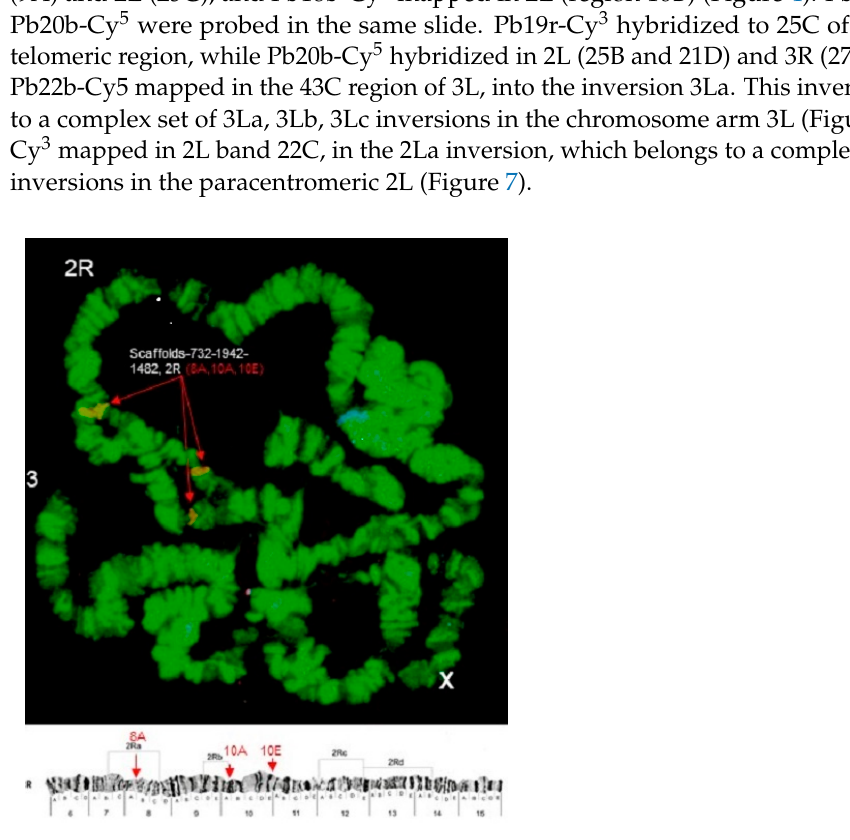
Figure 1. Pb2r-Cy3 probe, mapped in 2R (8A,10A, and 10E) indicated by arrows. 2Ra, 2Rb, 2Rc and 2Rd show inversions in 2R [19]. Chromosomal bands with positive hybridization are identified with text in red, and the corresponding scaffolds in An. darlingi genome assembly AdarC3 are indicated in white text.